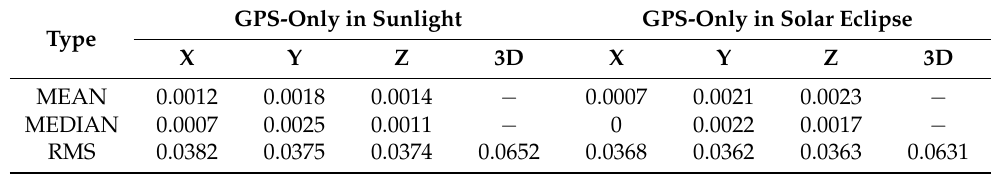
Table 8. Statistics of X, Y, Z and 3D residual (unit: m, days 121–242) in Sunlight and Solar